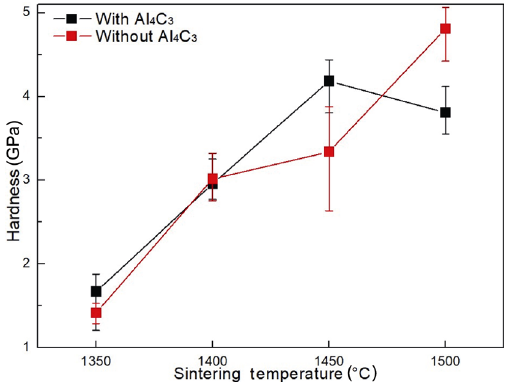
Dependence of the Vickers hardness on the sintering temperature of Ti 3 AlC 2 sample sintered with or without Al 4 C 3 embedding